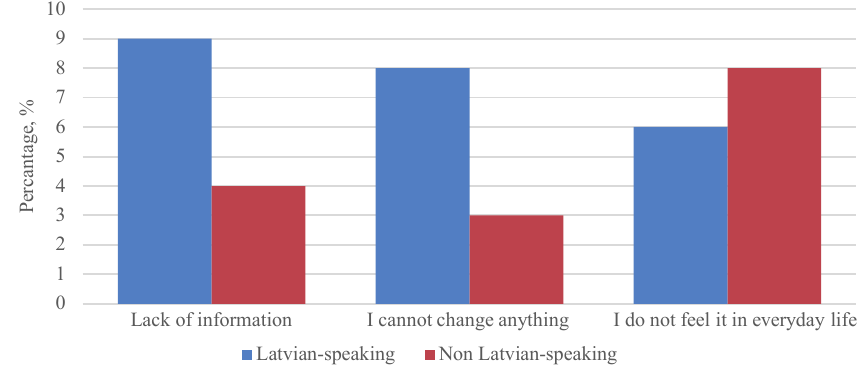
Fig. 5. Reasons why the problem seems